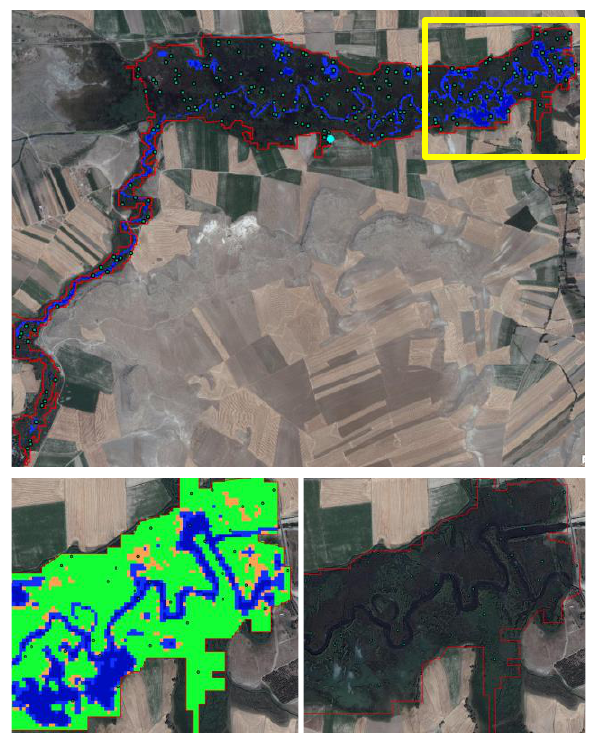
Table 2. NDVI and NDWI results